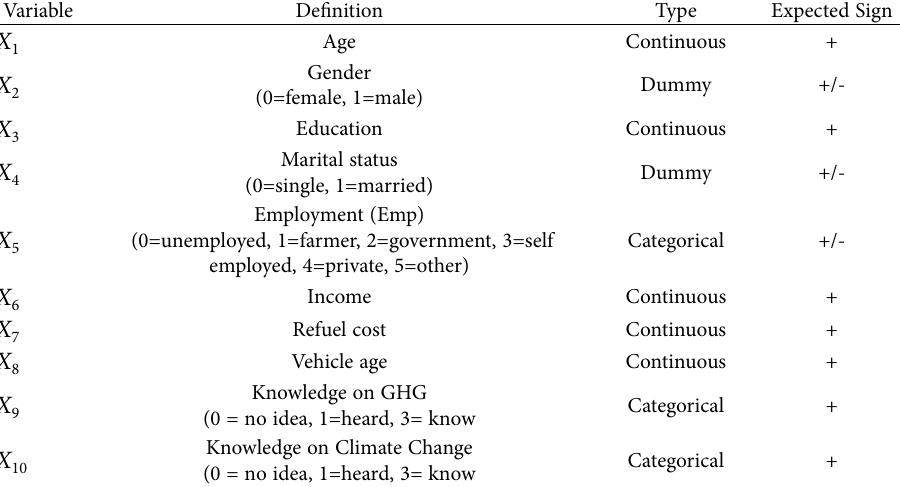
Table 1. Variables used in the probit